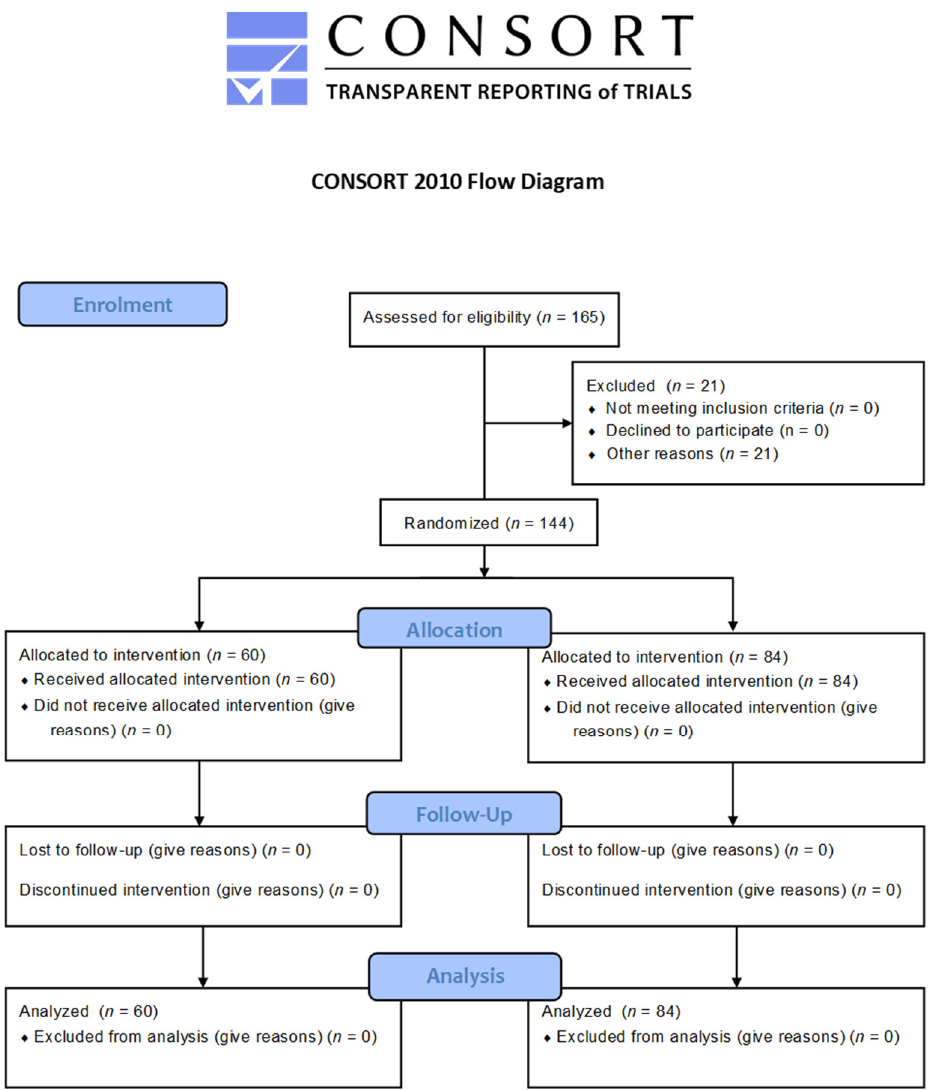
Figure 1. Flow diagram. A total of 144 participants completed the full study